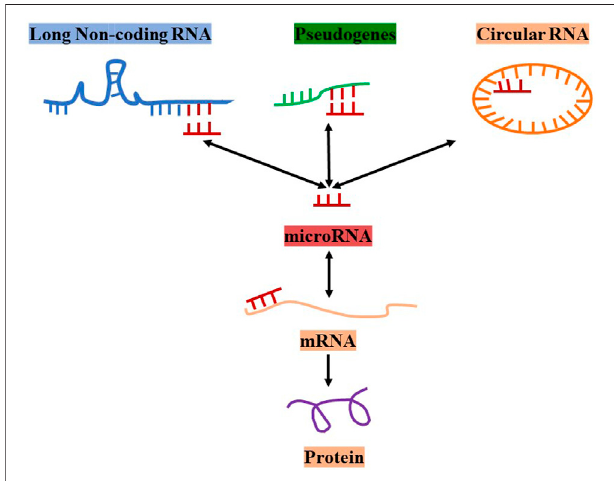
FIGURE 1 | The concept and types of